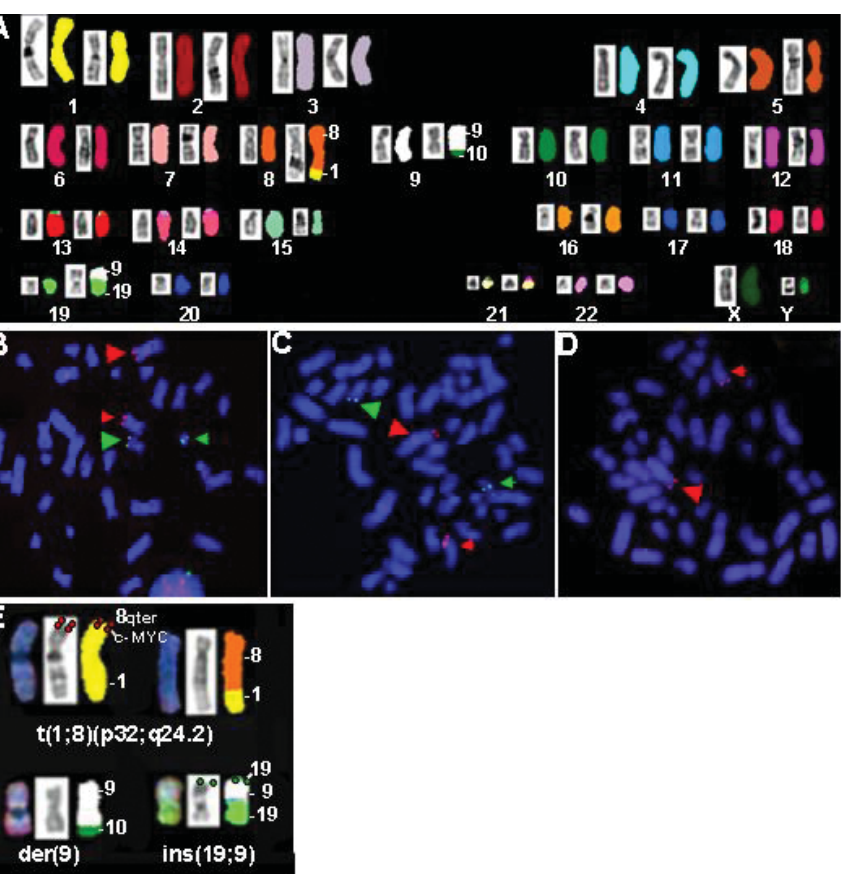
Figure 1 - Spectral karyotype (SKY) of leukemia cells from our patient at diagnosis of the disease. (A) Cell howing the band (left) and the classified (right) profiles for each chromosome. (B and C) Metaphases hybridized with the TelVysion 8q probe (labeled in red) and the 19p13.3 cosmid (labeled in green). Small arrows indicated the normal chromosomes 8 and 19 while large arrows indicate der(1)t(1;8) and ins(19;9)(p13.3;q22q24). These results suggest that t(1;8) is reciprocal and the breakpoint at 19p13 is proximal to the TCF3 (E2A) gene. (D). Metaphase hybridized with the C-MYC probe (la- beled in red). The small arrow indicates the normal chromosome 8 and the large arrow indicates der(1)t(1;8). These results indicate that the 8q breakpoint is proximal to the C-MYC locus in 8q24. (E). Montage illustrating the three clonal structural abnormalities suggested by the G-banding, SKY and metaphase FISH